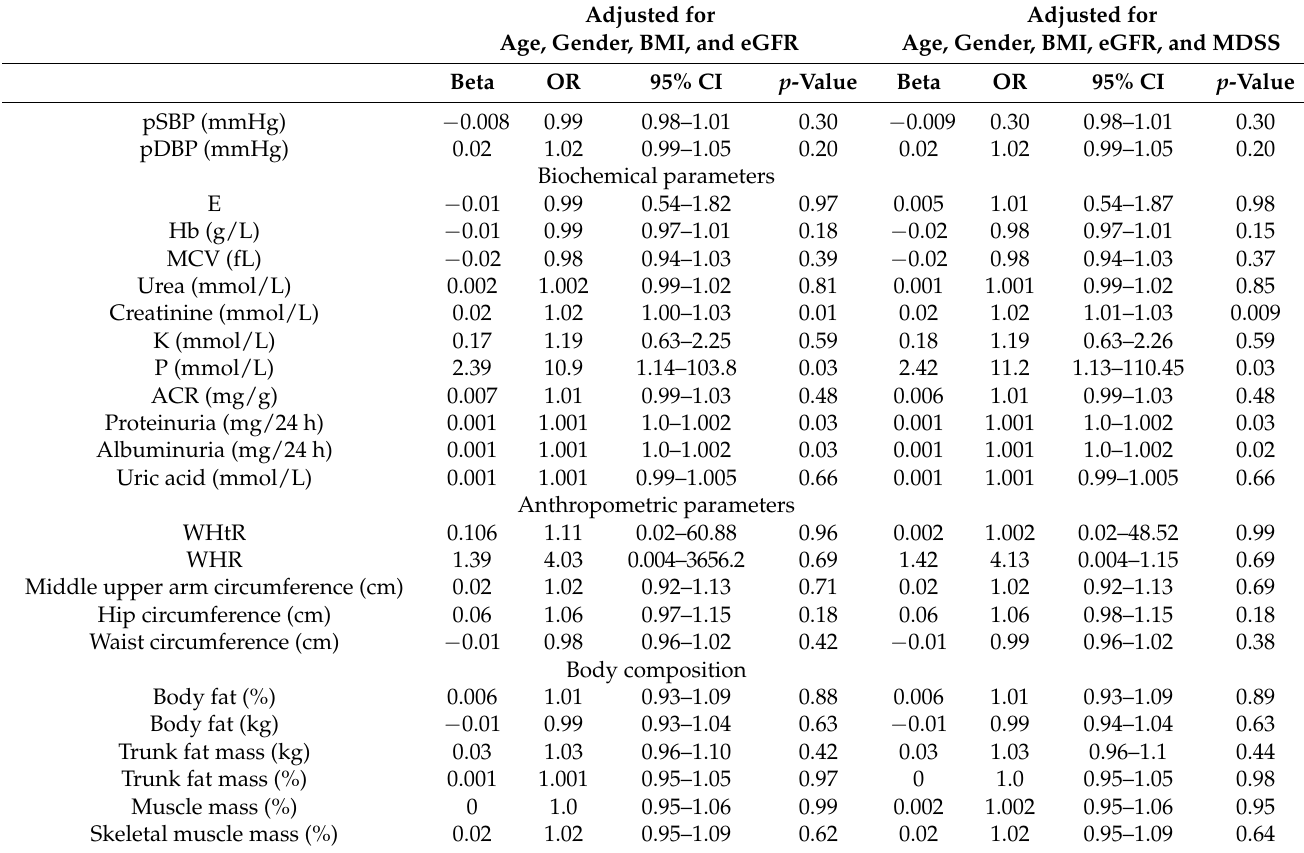
Table 4. Association of measured parameters and risk of development of CKD in